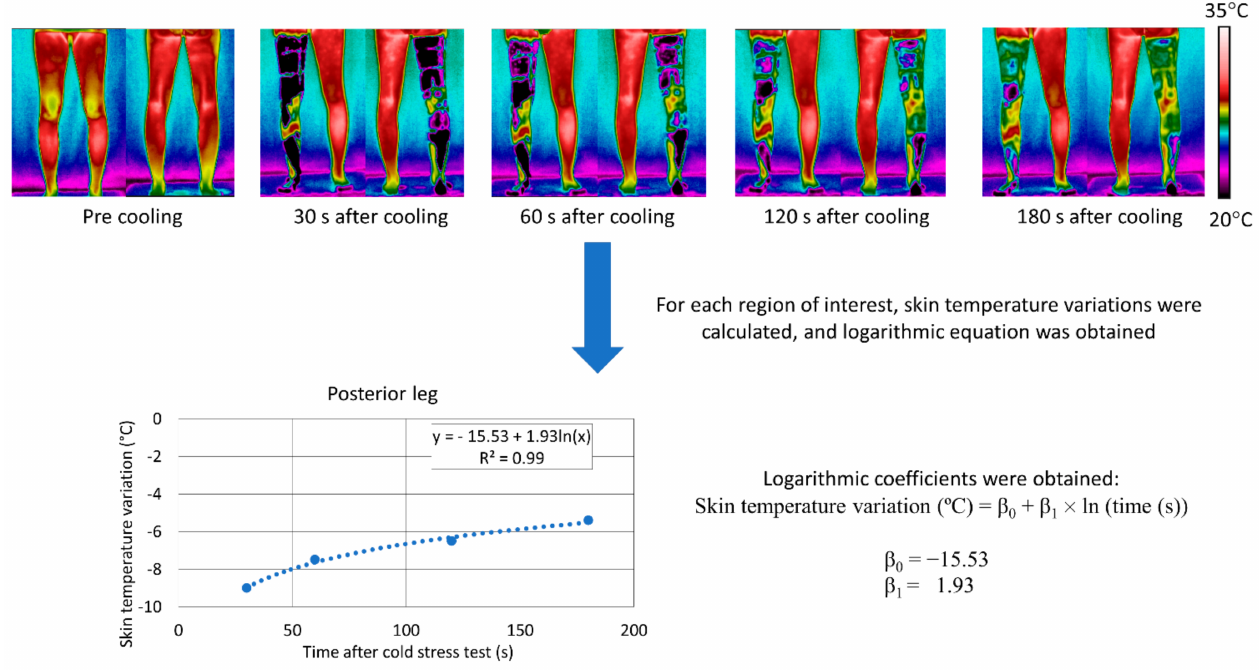
Figure 1. Regions of interest assessed in the preferred lower limb: (1) anterior thigh, (2) knee, (3) anterior leg, (4) posterior thigh, (5) posterior knee, and (6) posterior leg.